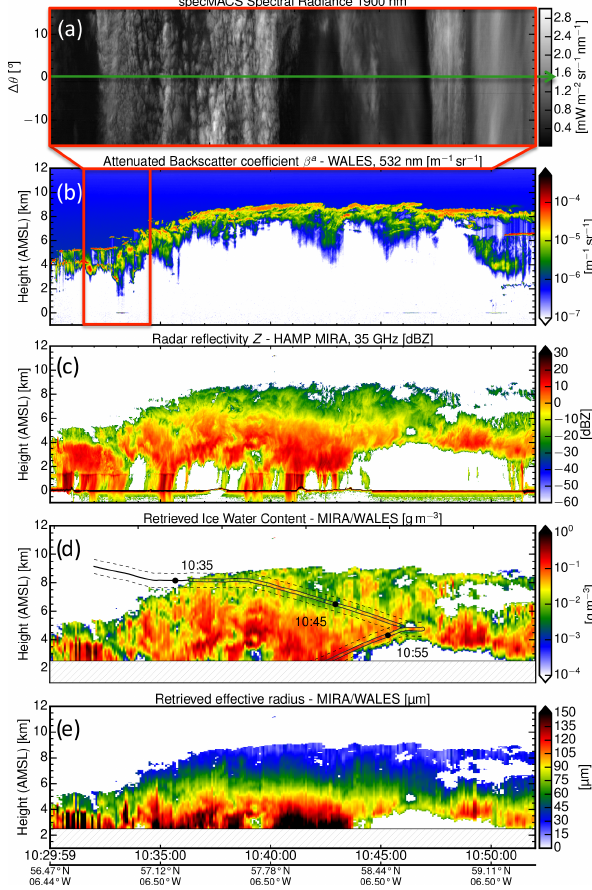
Figure 7. Remote sensing of a cirrus layer measured with HALO on 1 October 2016 during the NAWDEX campaign. (a) True-color im- age acquired by the hyperspectral cloud imager specMACS (Ewald et al., 2016) along the flight path, (b) attenuated backscatter coef- ficient measured with the WALES lidar at 532nm and correspond- ing (c) equivalent effective reflectivity Z e measured with the cloud radar HAMP MIRA at 35GHz. (d) Ice water content and (e) effec- tive radius of ice crystals retrieved by combining information from lidar (Fig. 7b) and (Fig. 7c) radar using the VarCloud framework.